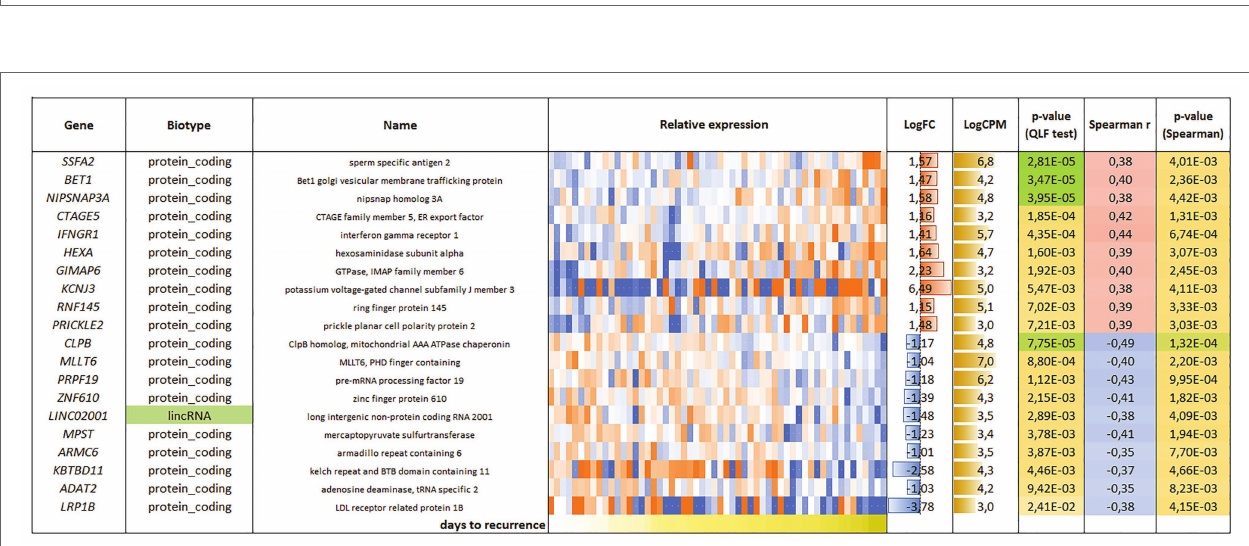
FIGURE 4 | List and heatmap demonstrating log relative expression level of genes with significant Spearman’s rank correlation coefficient relative to PFS for CRPC. For comments, see the Figure 3